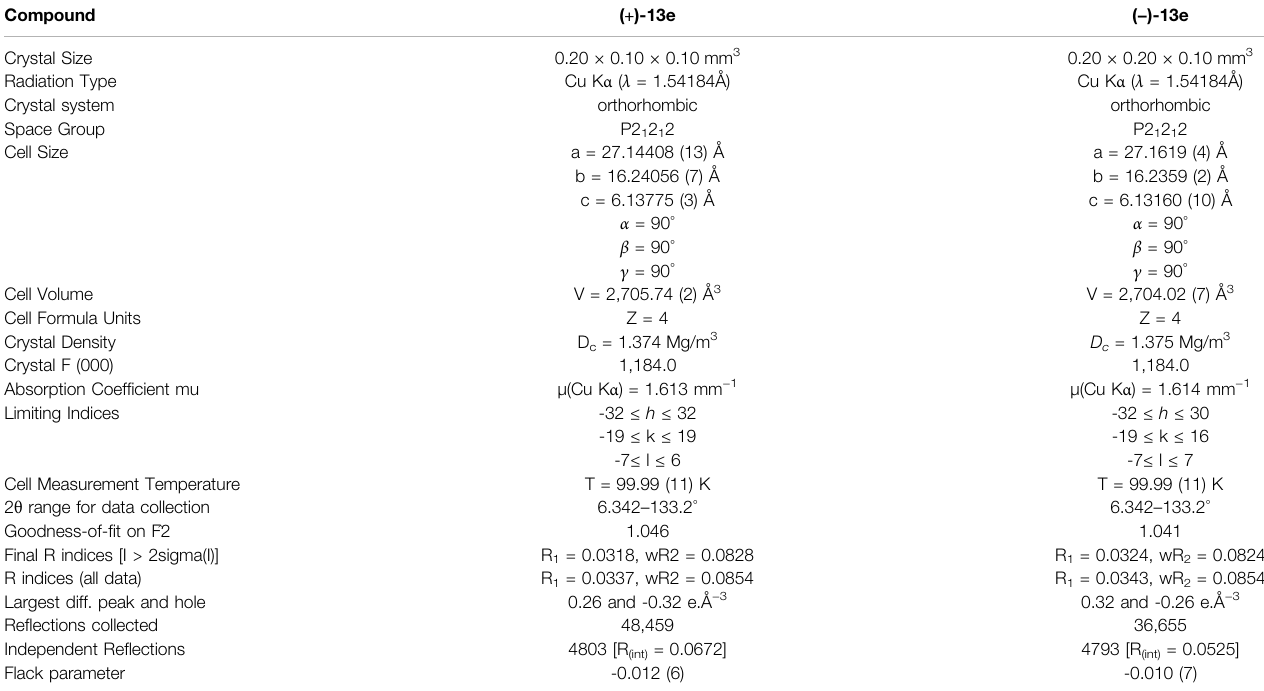
TABLE 1 | Summary of X-ray Crystallographic Data for (+)-9-tri fl uoroethoxy- α -dihydrotetrabenazine [(+)-13e] and its enantiomer ( − )-13e.